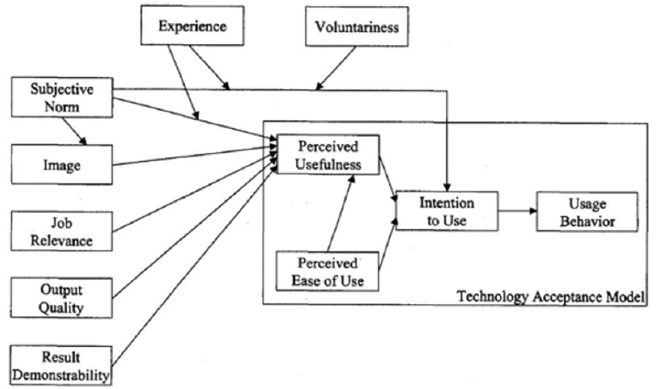
Fig. 3. TAM2 - Extension of the Technology Acceptance